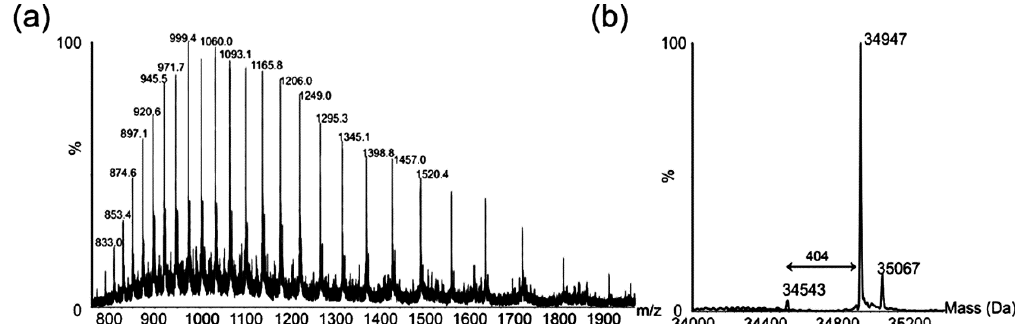
Figure 4. Electrospray mass spectrometry of intact polar flagellin proteins from Aeromonas hydrophila AH-1. ( a ) Electrospray mass spectrum of intact polar flagellin proteins showing a complex envelope of multiply charged protein ions; ( b ) The reconstructed molecular mass profile of these polar flagellins resolves three masses at 34,543, 34,947, and 35,067 Da.